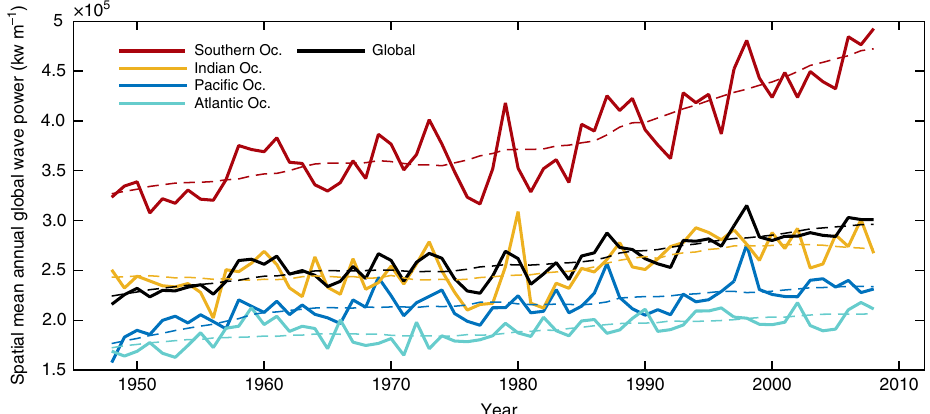
Fig. 1 Spatial mean annual Wave Power calculated globally and by ocean basin. The dashed lines represent the 10-year moving averages. The Southern Ocean is de fi ned between latitudes of 40°S and 80°S. The mean regional Wave Power is calculated as the spatial average of each historical wave power time series (see Methods). The solid lines indicate each time series. The dashed lines correspond to the 10-year moving average. The time series calculated by latitudinal bands can be found in Supplementary